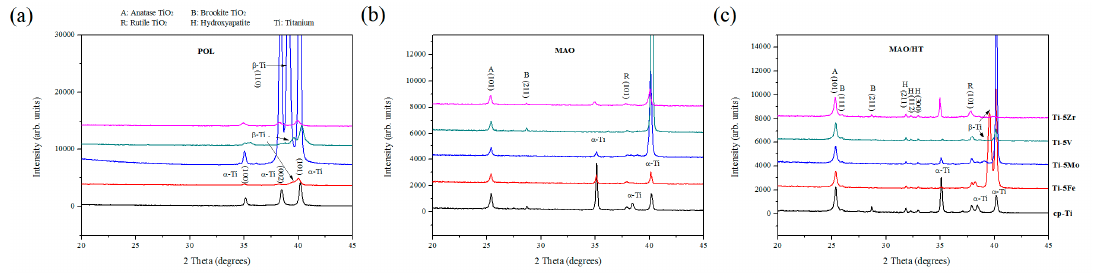
Figure 2. XRD patterns of ( a ) polished (POL), ( b ) MAO and ( c ) MAO/hydrothermally treated (HT)